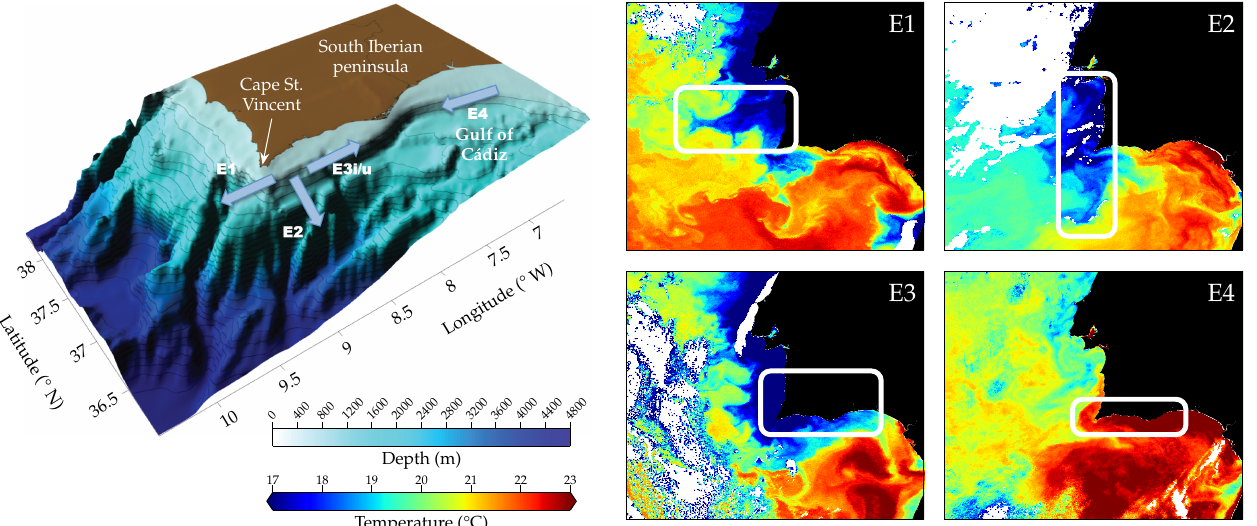
Figure 2. Left : depth map of the Atlantic Ocean around the southwestern coast of the Iberian peninsula. The arrows show the direction of the water currents during a mesoscale event. Right : examples of SST maps with recognisable events patterns (highlighted in the